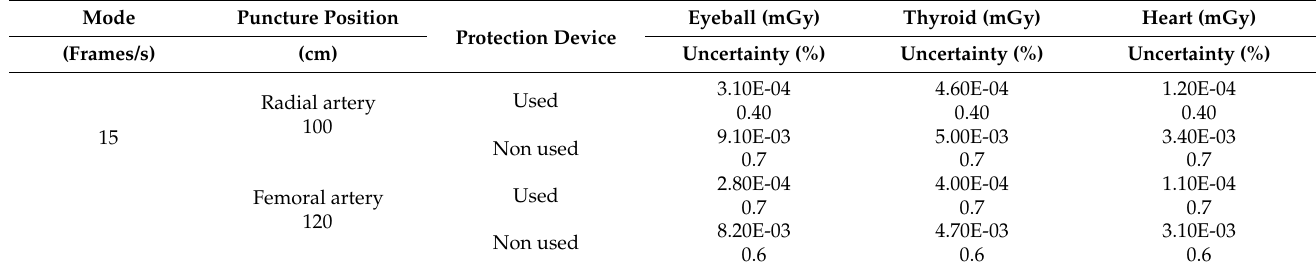
Table 2. Monte Carlo N-particle code-simulation results of each exposure condition for the organ doses of the eyeball, thyroid, and heart of cardiac operator.